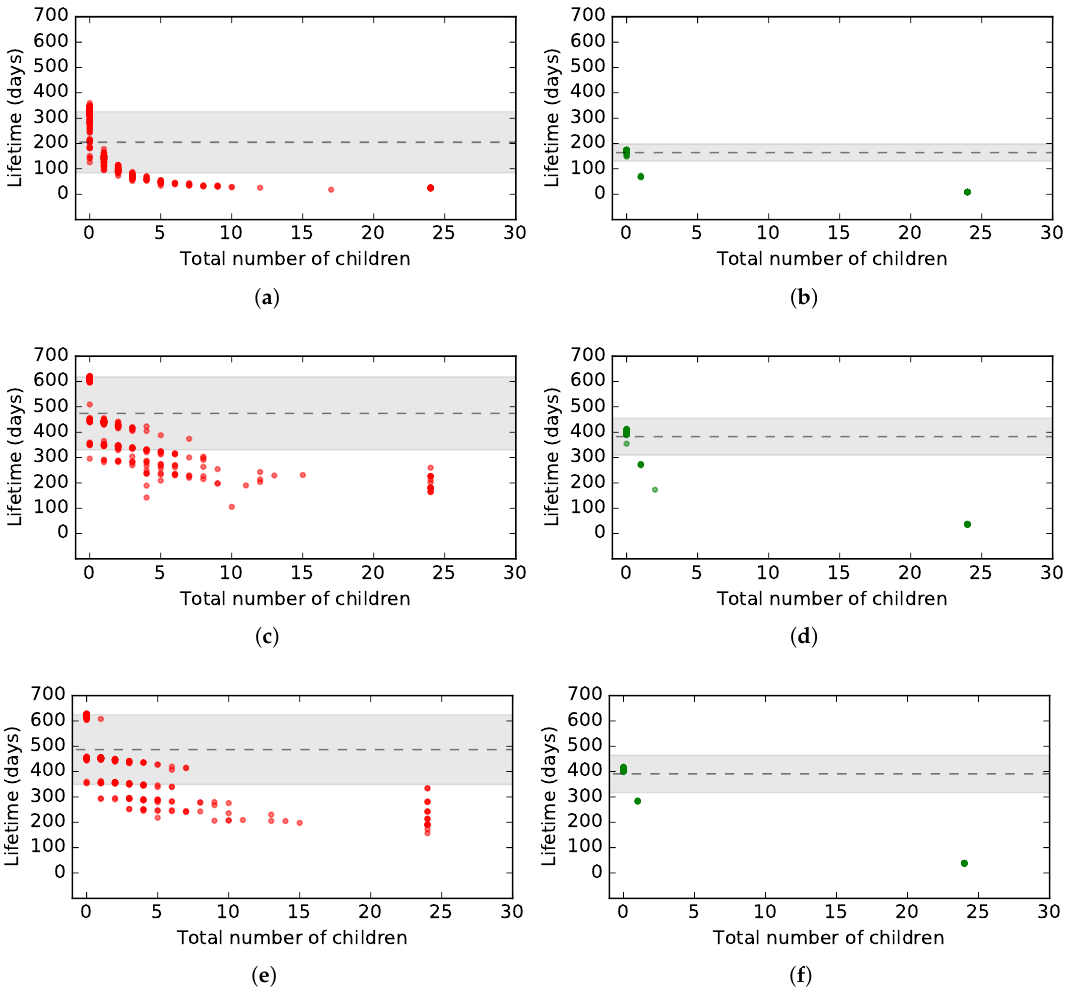
Figure 12. Comparison of the lifetime of a TSCH node, running on two AA batteries, between 2.4GHz and 868MHz communication for different packet periods in a grid topology of 25